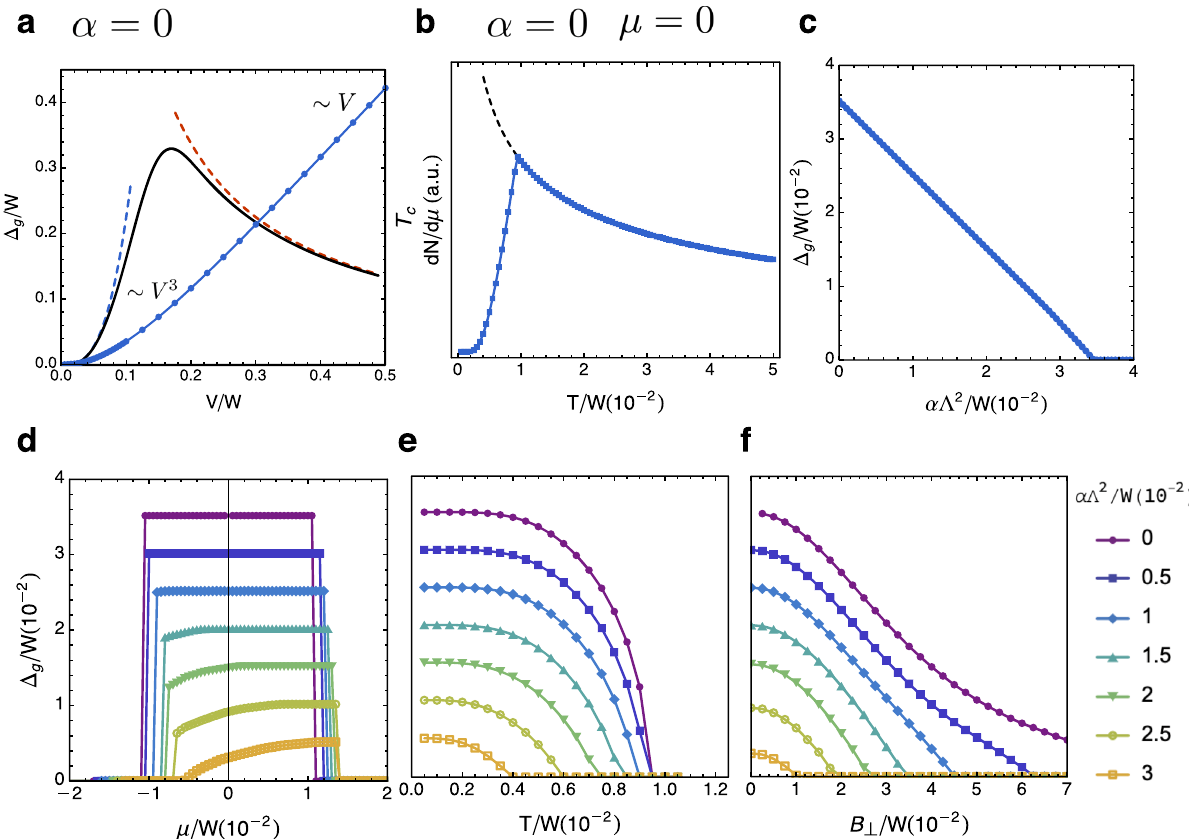
Fig. 2 The intervalley exciton order. a The mean- fi eld exciton order parameter (blue) and the schematic plot of T c (black) as a function of interaction strength for the case of α = 0. b The mean- fi eld electronic compressibility dN / d μ as a function of temperature at α = 0 and μ = 0. c The quasi-particle gap as a function of α with T = 0 and B ⊥ = 0 at half- fi lling. d The quasi-particle gap as a function of μ with T = 0 and B ⊥ = 0. e The quasi-particle gap as a function of T with B ⊥ = 0 at half- fi lling. f The quasi-particle gap as a function of B ⊥ with T = 0 and μ = 0. Taking the valley Zeeman g -factor to be ~10 55 , the range of magnetic fi eld in ( f ) is 0 ~ 12 T, which is comparable to the experimental available range. All data in ( b – f ) are obtained with V = 0.1 W